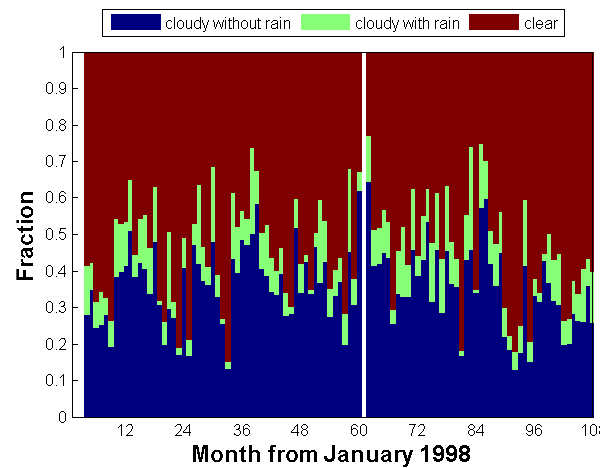
Fig. 1. Monthly mean cloud occurrence at the Atmospheric Radi- ation Measurement (ARM) Southern Great Plains (SGP) site from 1998 to 2006 based on the MICROBASE product. The length of each bar represents the fraction of occurrence. The University of Utah (UU) product (not shown here) shows almost identical sea- sonal variation. A profile is clear if the total cloud water content (liquid and ice) is zero, and otherwise it is cloudy. A profile is con- sidered to be raining if there is at least one layer below the freezing level with radar reflectivity Z > −